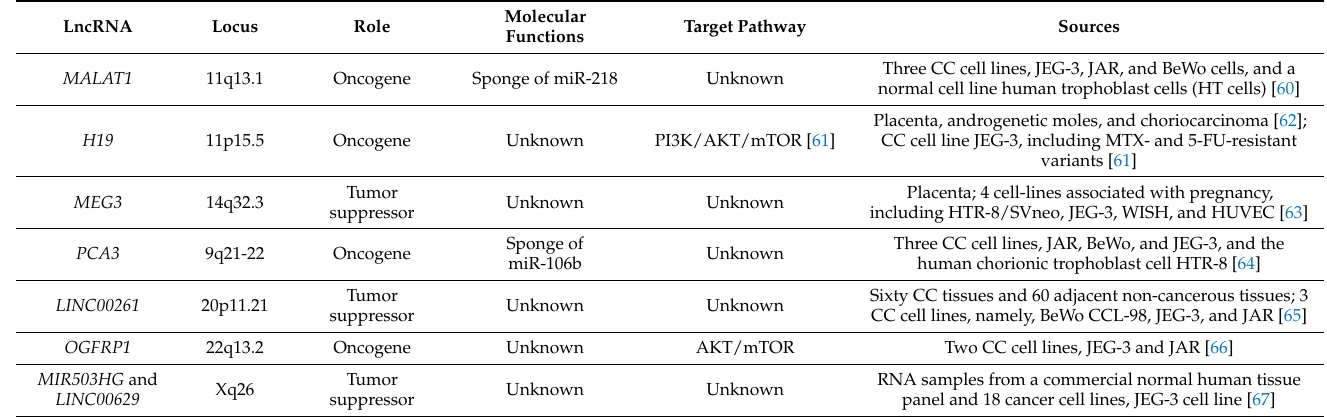
Table 4. LncRNAs with a role in